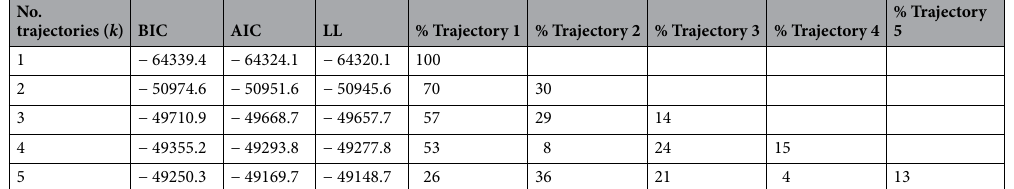
Table 1. Fit statistics and class prevalence for models with k latent trajectories. Notes: Based on individuals with at least three completed waves on psychological distress ( N = 15,914 ). BIC: Bayes Information Criterion, AIC: Akaike Information Criterion, LL: